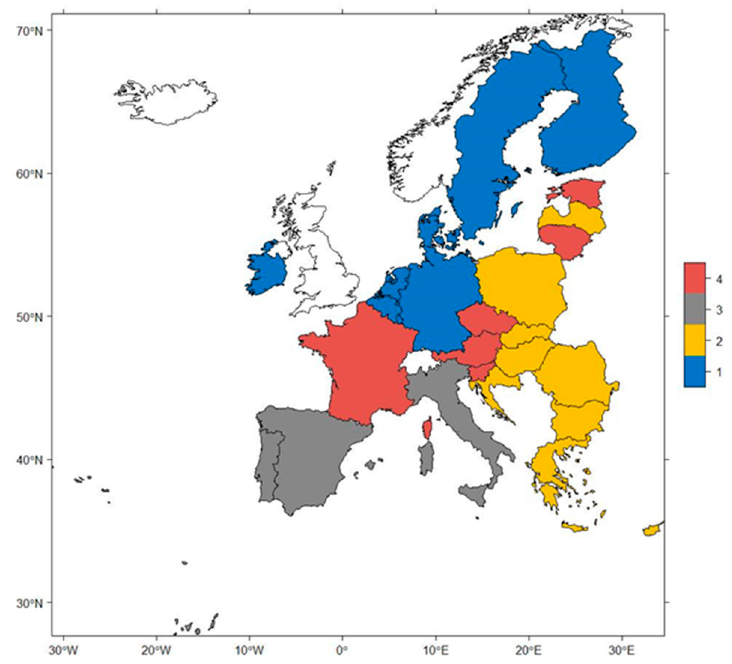
Figure 3. Clustering results presented on the map of Europe. Source: Author’s elaboration.